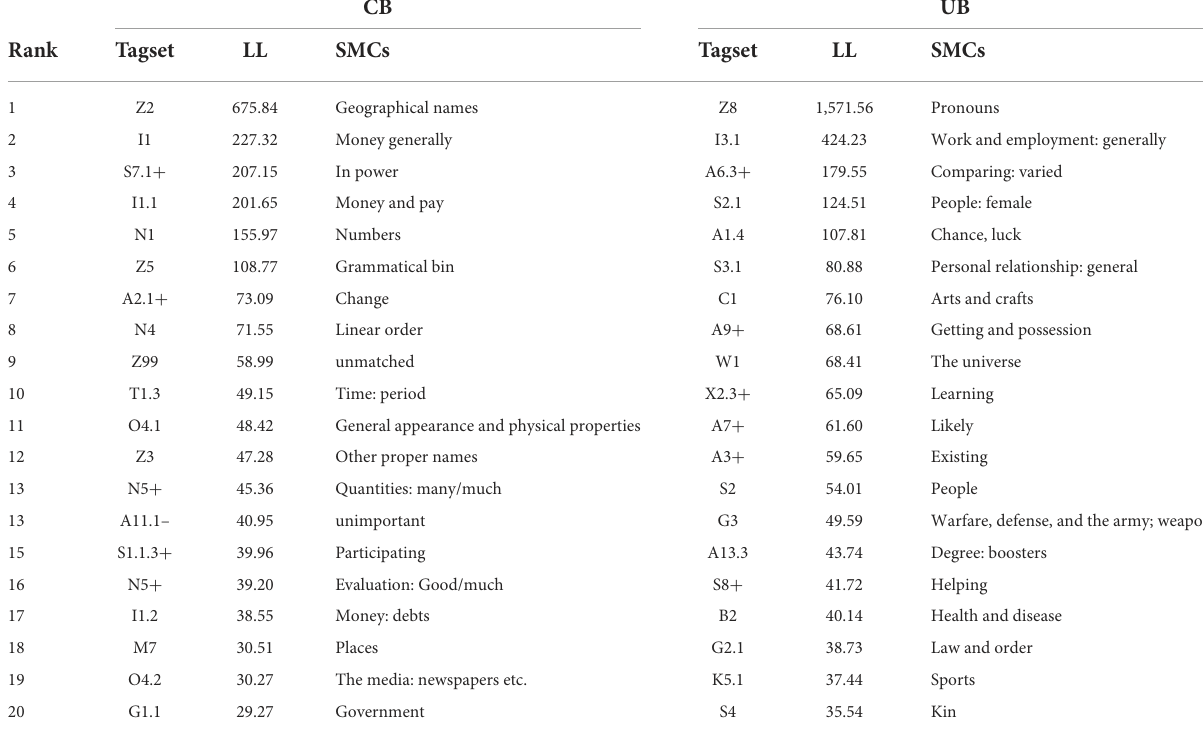
TABLE 5 Top 20 SMCs in CB and UB compared with each